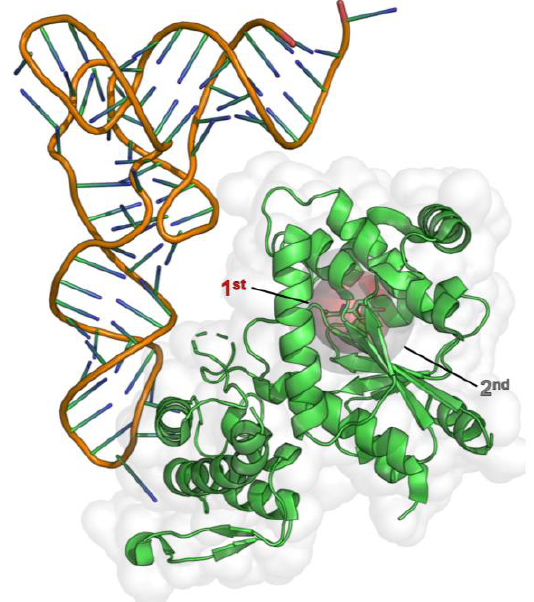
Figure A1. Mj TyrRS-tRNA Tyr complex wild type structure with shells around the substrate Tyr (shown as sticks) highlighted. In the aaRS crystal structure with bound tRNA (PDB ID 1J1U), two shells—6 Å (red) or 9 Å (gray)—around the center of mass of the bound substrate are modeled. The solvent-accessible surface of the protein is indicated in light gray.